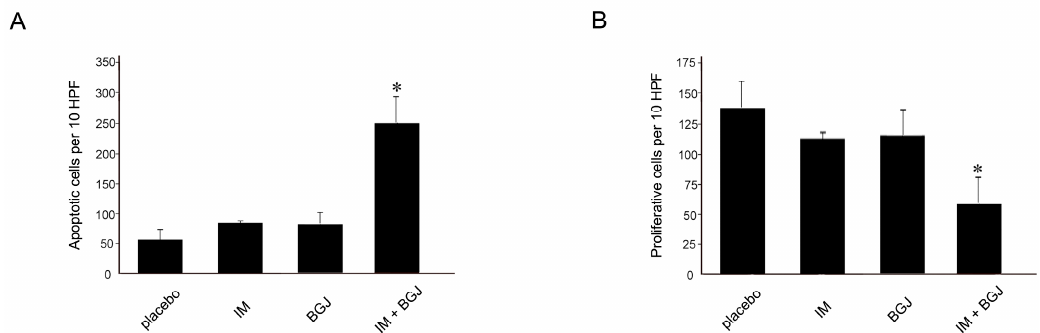
Figure 6. Pro-apoptotic activity and anti-proliferative activities of IM and BGJ398 in a murine GIST xenograft model. Quantification of the apoptotic cells visualized by immunohistochemical (IHC) staining for cleaved caspase-3 ( A ), or proliferative cells stained for Ki-67, a proliferative marker ( B ), in GIST xenografts treated with IM or BGJ398 alone or in combination in comparison with a placebo. At least six tumors per group were examined. Columns: mean + SE; * p ≤ 0.05.